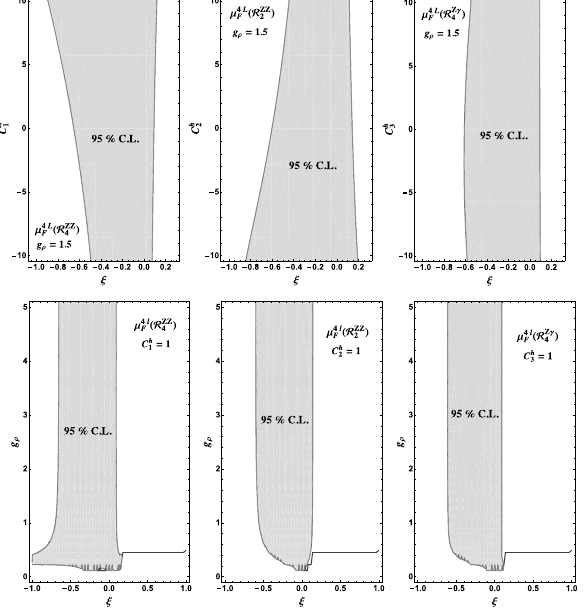
,ξ) plane using using i